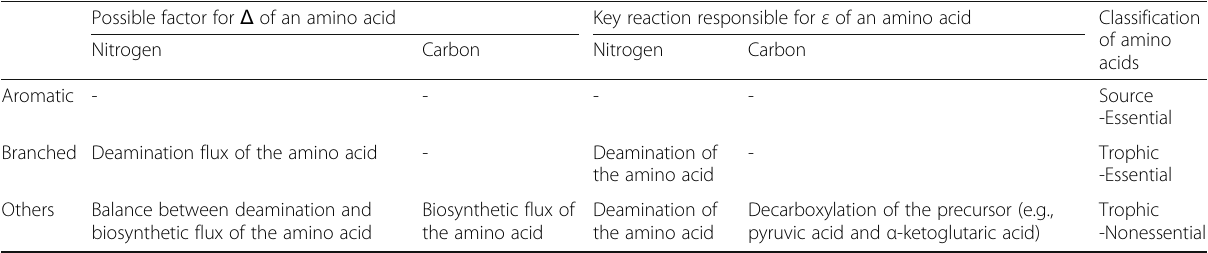
Table 3 Possible factors for controlling trophic discrimination ( Δ ) and key reactions responsible for isotopic fractionation ( ε )